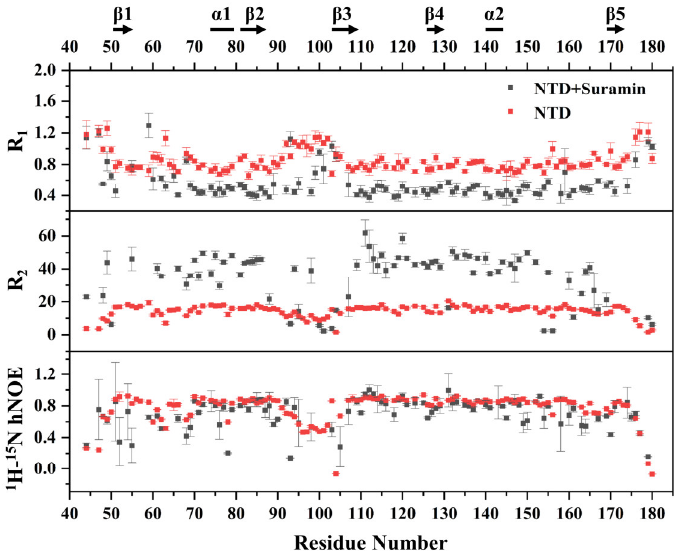
Figure 7. NMR-measured backbone relaxation parameters R 1 , R 2 and hNOE values of free N-NTD and suramin-bound N-NTD.